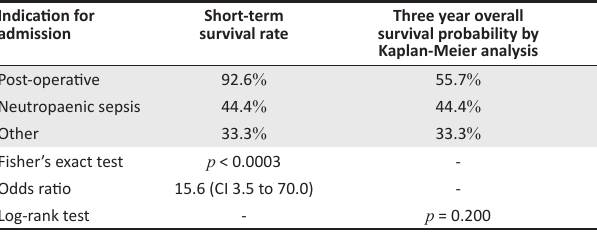
FIGURE 3: Causes of death during paediatric intensive care unit admission. TABLE 1: Short-term and long-term survival based on indications for paediatric intensive care unit